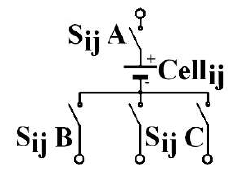
Figure 5. C3C element.